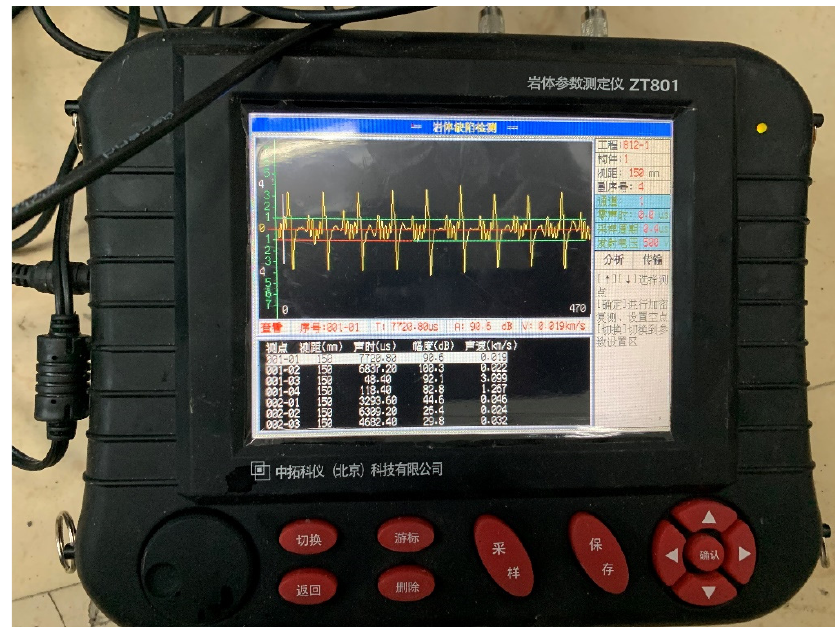
Figure 3. ZT801 Geotechnical Acoustic Tester.